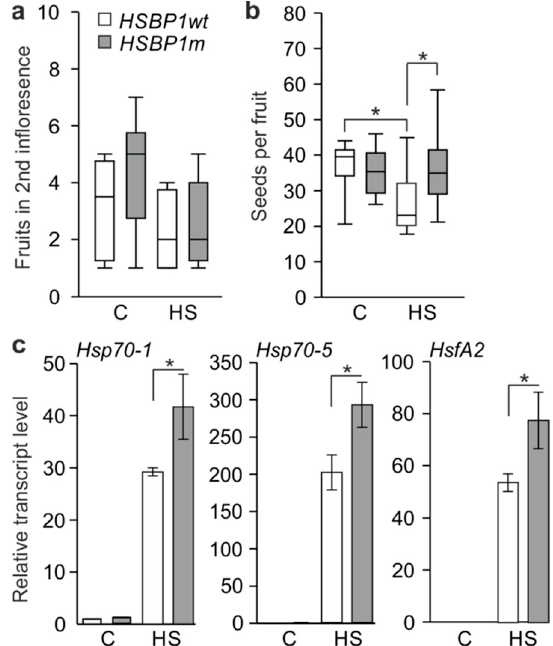
Figure 6. Thermotolerance of SlHSBP1wt and SlHSBP1m lines. ( a ) Number of fruits from the second trust and ( b ) number of seeds per fruit are shown in box plots, including the median and the upper and lower quartiles ( n = 8) in control (non-stressed) and heat-stressed SlHSBP1wt and SlHSBP1m plants treated as described above. Asterisks indicate significant differences between the indicated samples, based on Student’s t -test ( p < 0.05). ( c ) Transcript levels of Hsp70-1 , Hsp70-5 , and HsfA2 in control and heat-stressed SlHSBP1wt and SlHSBP1m plants. Expression values are normalized against the SlHSBP1wt control sample determined by qRT-PCR. Values are the average of three biological replicates ±SD. Asterisks denote a significant difference ( p < 0.05) based on pairwise t-test analysis.